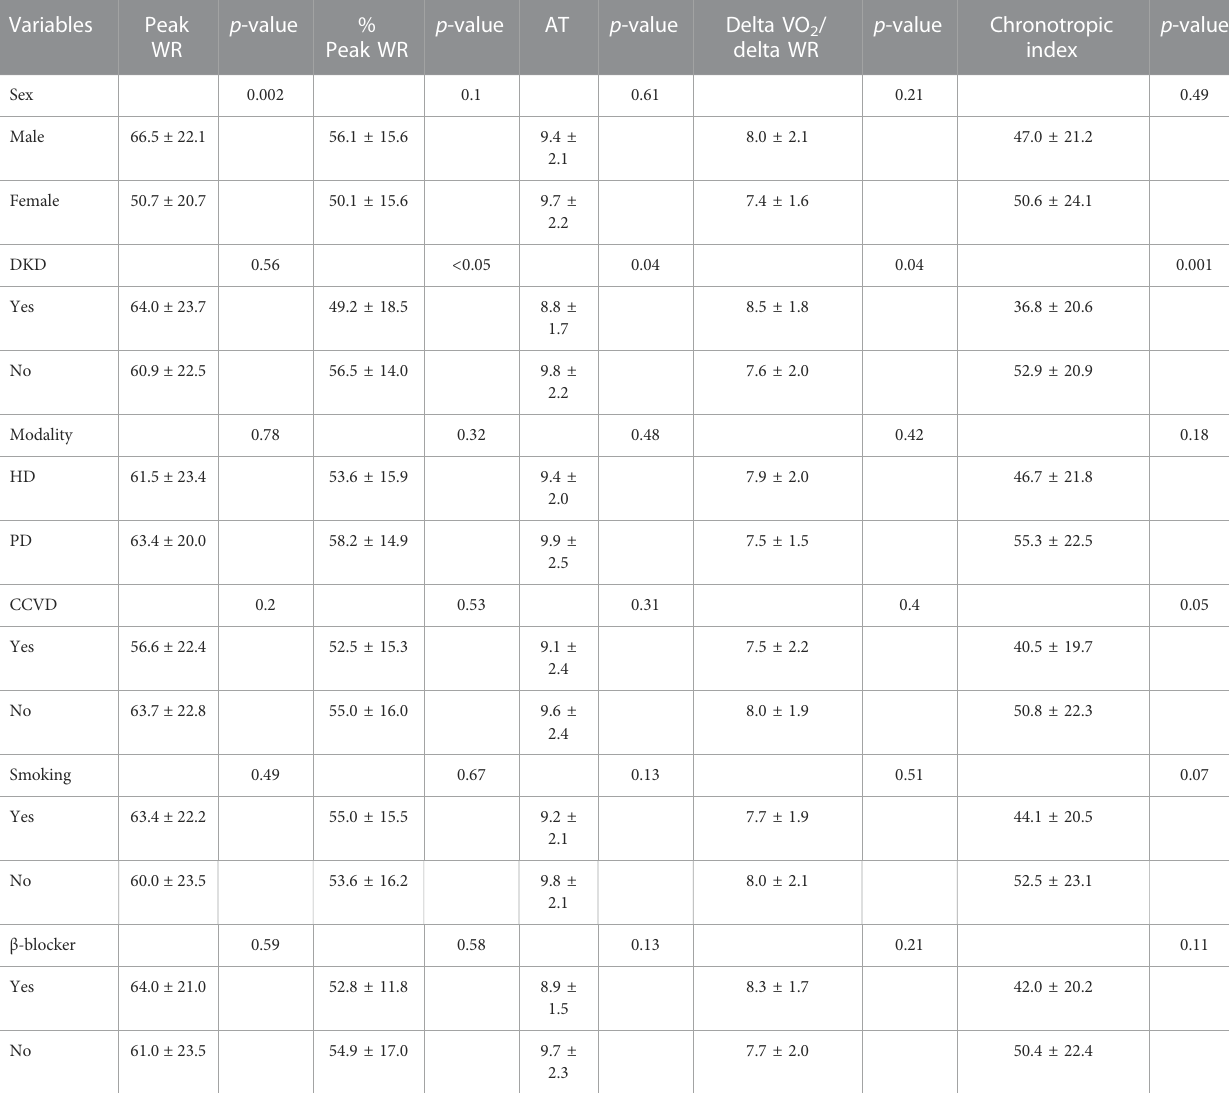
TABLE 3 Comparisons of secondary outcomes between subgroups.